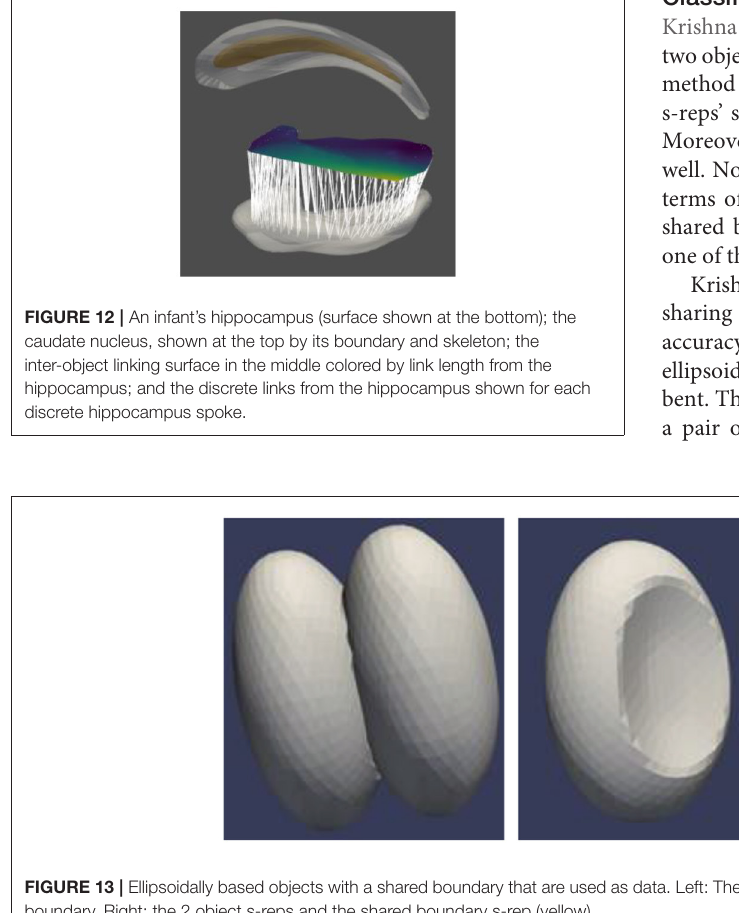
Frontiers in Computer Science |